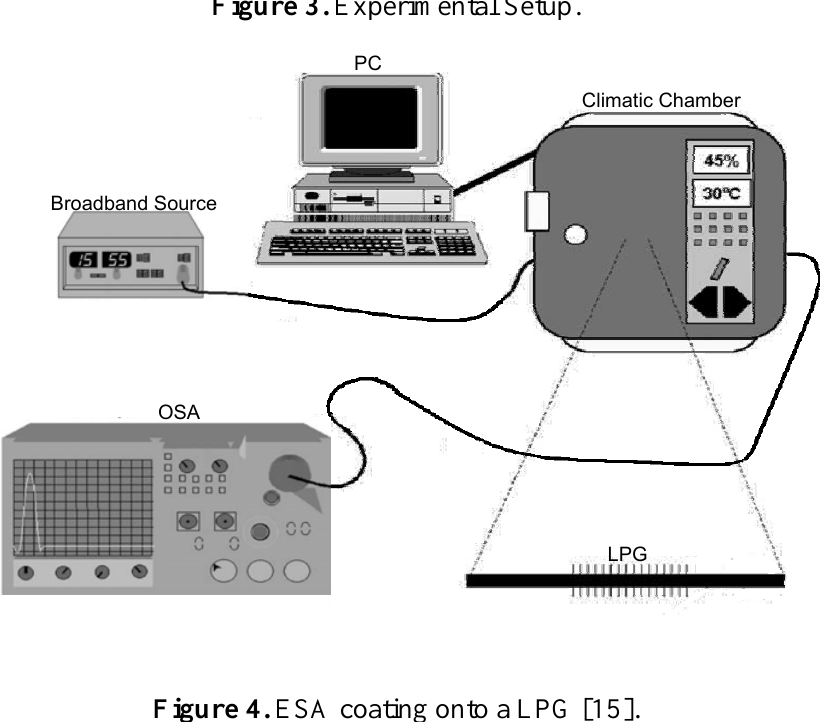
Figure 3. Experimental Setup.